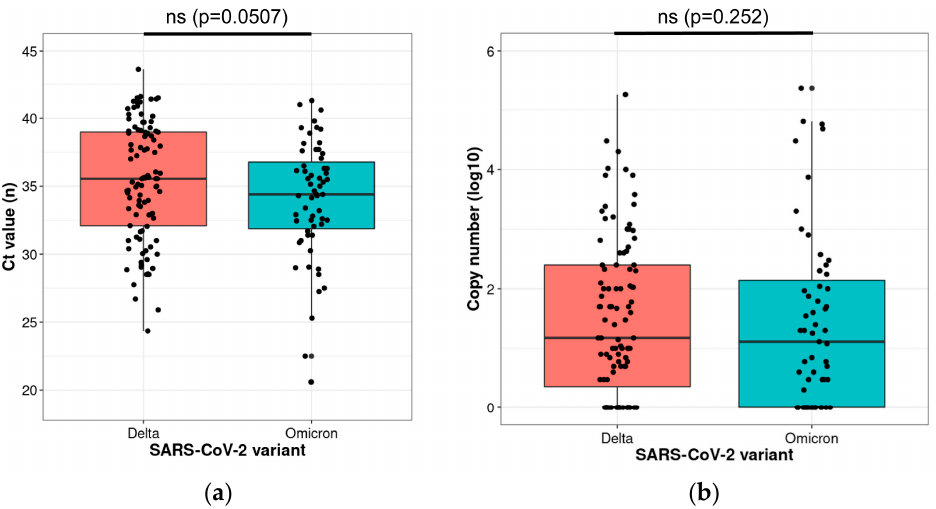
Figure 2. ( a ) Cycle Threshold (Ct) value of Idylla RT-PCR assay according to the SARS-CoV-2 variant; ( b ) Viral load according to SARS-CoV-2 variant. Delta, n = 100 samples; Omicron, n = 59 samples. Boxplot and scatter dot plot representation. Dots outside whiskers are considered outliers. ns = non-significant. Unpaired Student’s t-test.